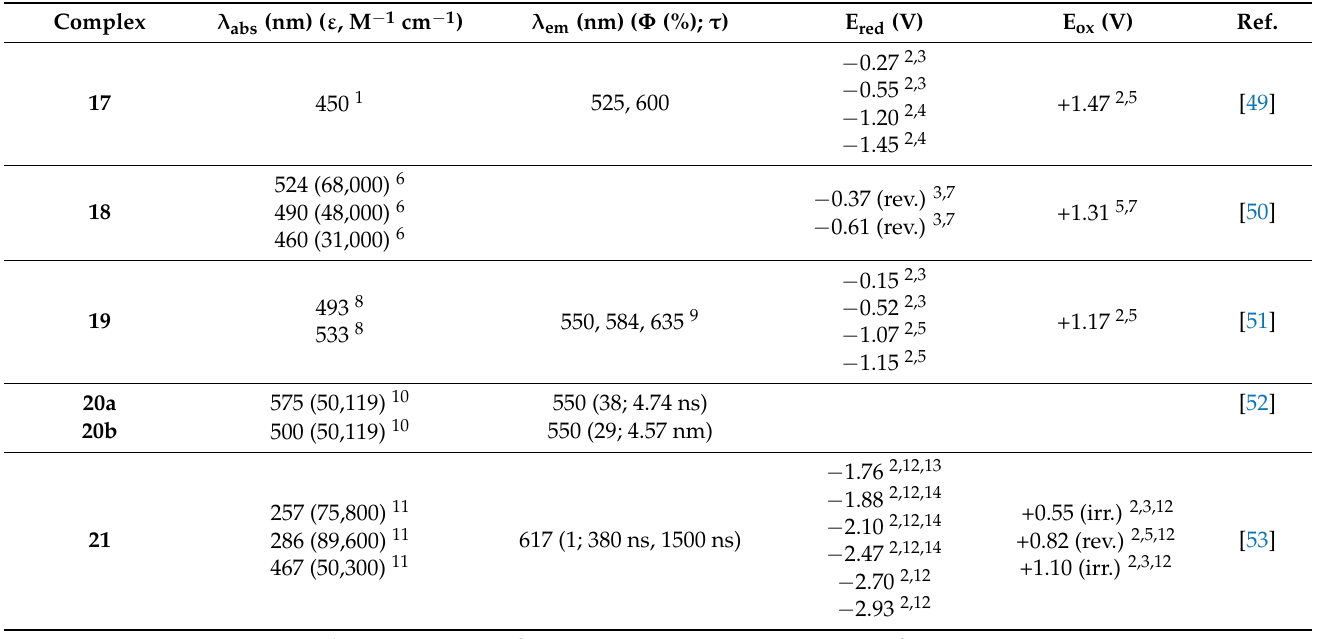
Table 3. Photophysical and redox properties of complexes 17 , 18 , 19 , 20a – b , and 21 .